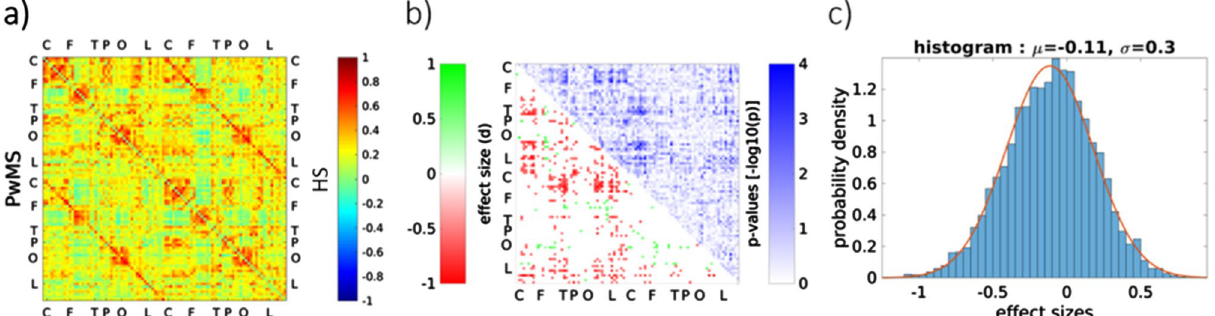
Figure 3. ( a ) the adjacency matrix of HS in the upper triangle matrix and PwMS in the lower triangle matrix. ( b ) results of the permutation tests between all edges, PwMS relative to HS ( c ) distribution of all effect sizes of the permutations with p-value < 0.05.